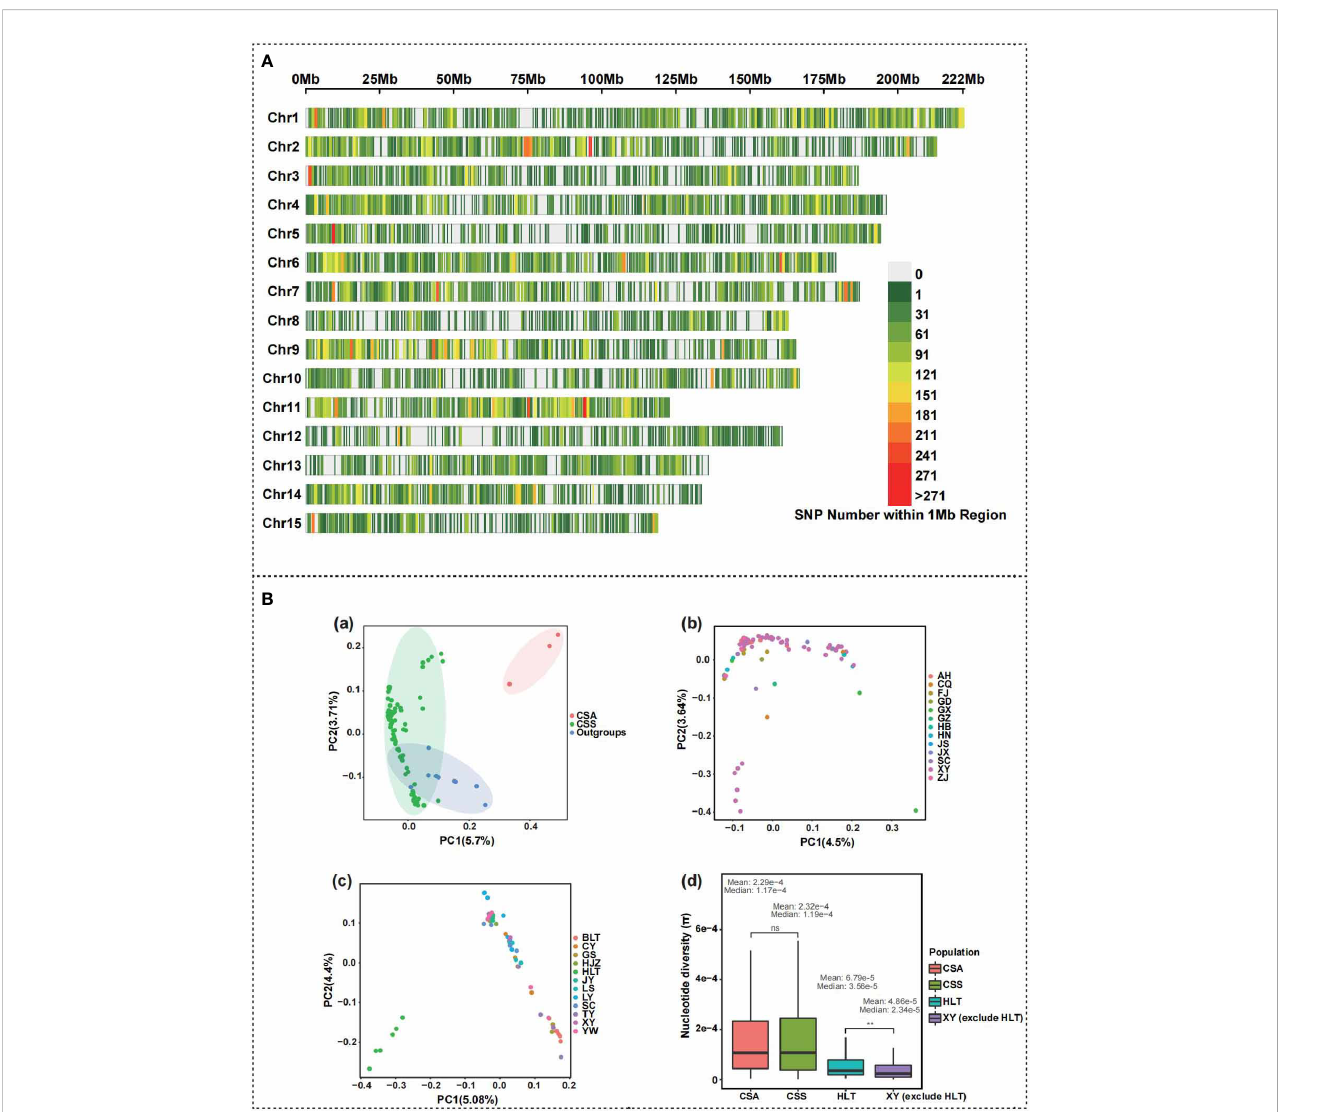
FIGURE 2 Principal component analyses and genetic diversity calculation by SNPs of 108 Camellia samples. (A) Distribution and density map of identi fi ed SNPs on 15 chromosomes of Camellia sinensis var. sinensis . (B) Principal component analysis (PCA) of 108 Camellia accessions for samples clustering. (a) The result of PCA of 108 Camellia samples. CSS indicate Camellia sinensis var. sinensis population; CSA indicates Camellia sinensis var. assamica population. Red, green and blue ellipses represent CSA, CSS and wild tea population, respectively. (b) The result of PCA of 92 Camellia sinensis var. sinensis samples. AH, Anhui; CQ, Chongqing; FJ, Fujian; GD, Guangdong; GX, Guangxi; GZ, Guizhou; HB, Hubei; HN, Hunan; JS, Jiangsu; JX, Jiangxi; SC, Sichuan; XY, Xinyang; ZJ, Zhejiang. (c) The result of PCA of 59 Camellia sinensis var. sinensis samples from Xinyang City. BLT, Bailongtan; CY, Mount Cheyun; GS, Gushi County; HJZ, Hejiazhai; HLT, Heilongtan; JY, Mount Jiyun; LS, Luoshan County; LY, Mount Lianyun; SC, Shangcheng County; TY, Mount Tianyun; XY, Xinyang; YW, Mount Yunwu. (d) The comparison of nucleotide diversity between Camellia sinensis var. sinensis (CSS) with Camellia sinensis var. assamica (CSA) population, and between Xinyang Heilongtan (CSS HLT) with Xinyang except for Heilongtan (XY except for HLT) samples. The mean and median nucleotide diversity values were above the box for each tea population. The results of the signi fi cance tests are indicated using ns (no signi fi cant difference) and ** (p <